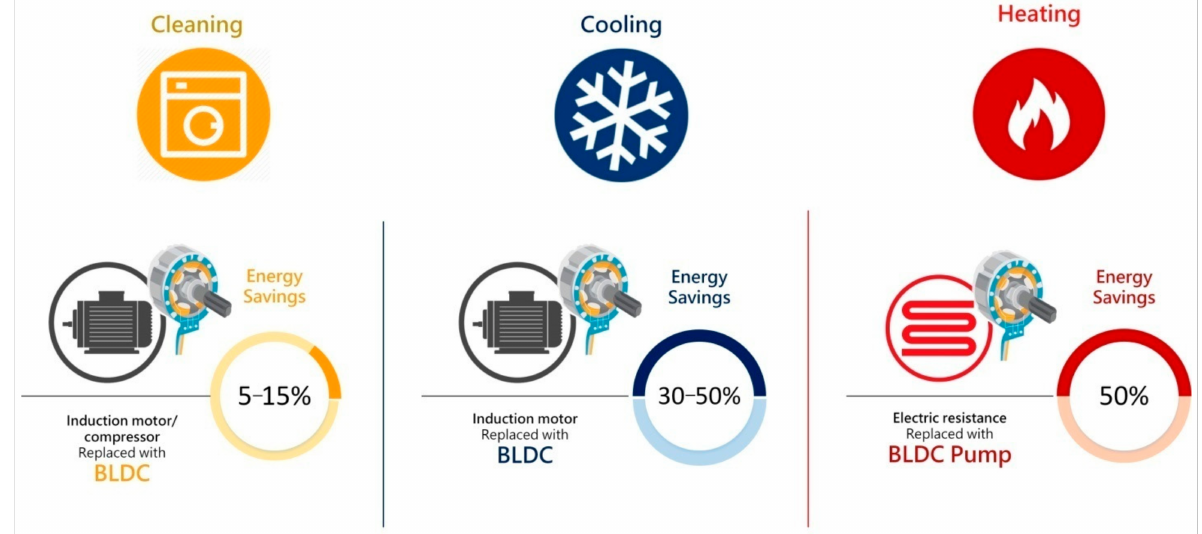
Figure 6. Replacement of conventional induction motor with DC